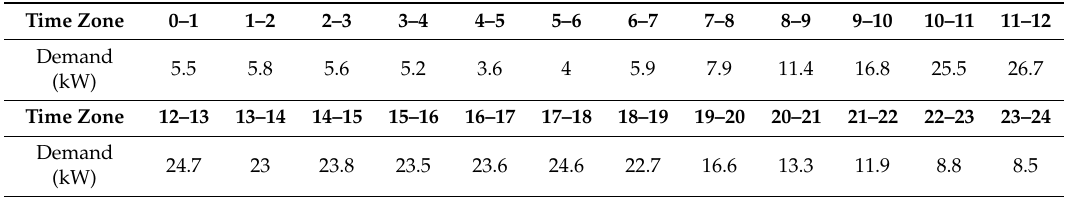
Table 4. Forecast prices of power demand schedule (virtual data)